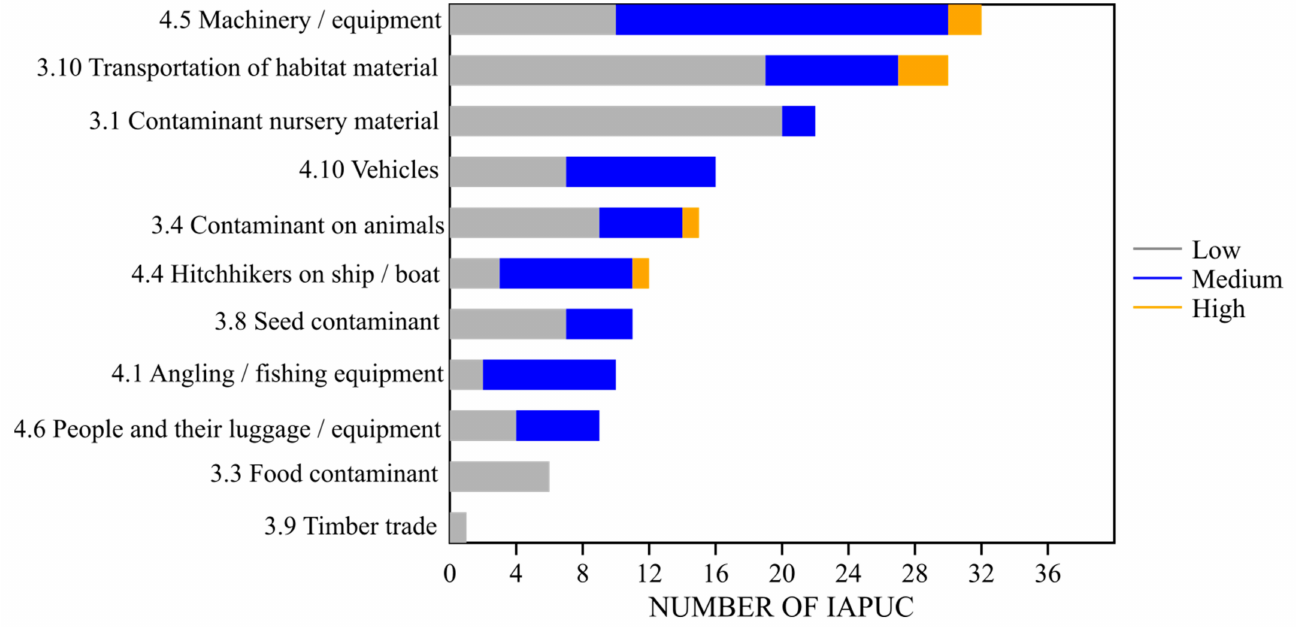
Figure 1. IAPUC introduced and spread as contaminants and/or stowaway in agriculture: represen- tativeness of unintentional pathways of introduction and spread and their likelihood (grey = low, blue = medium, orange =